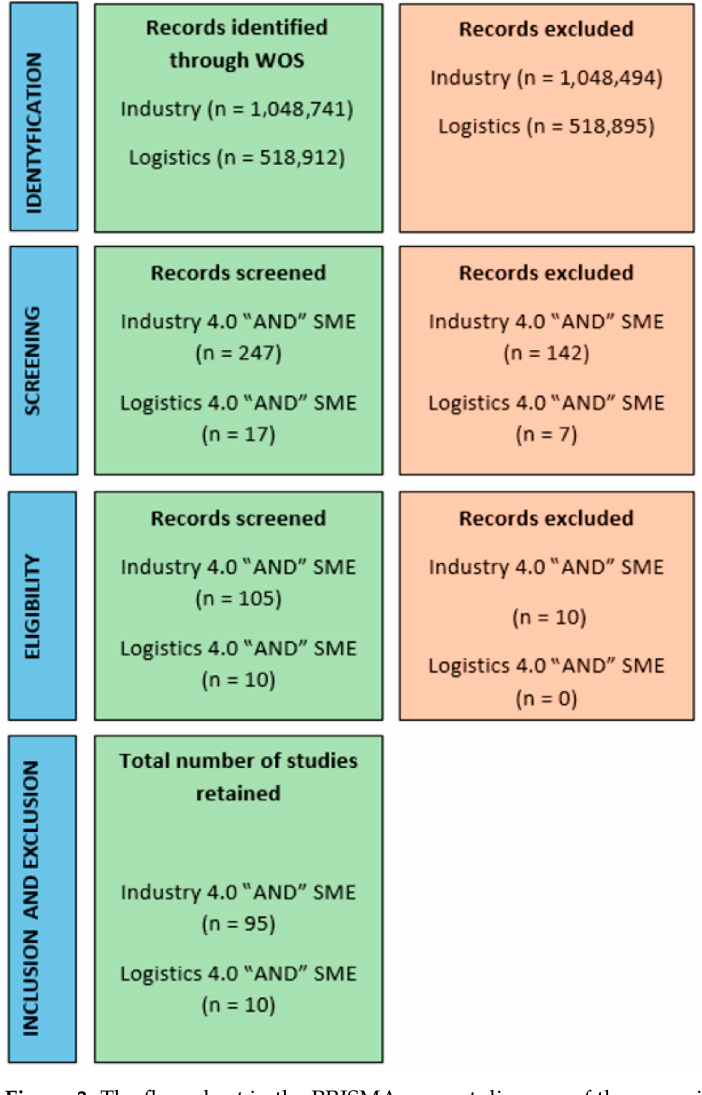
Figure 3. The flow chart in the PRISMA consort diagram of the screening and selection of